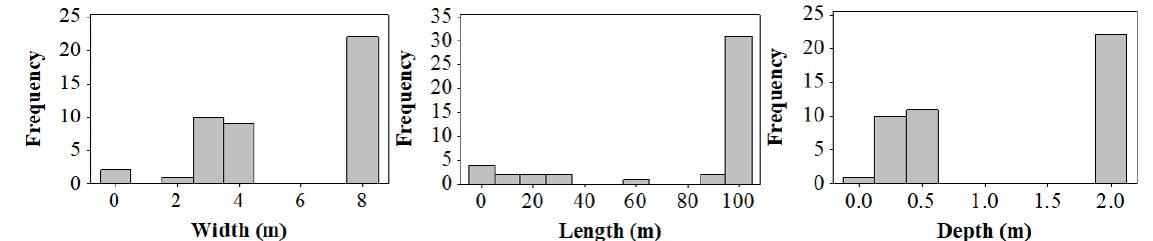
Figure 7: Histograms depicting the depth, length, and width of the extent of the spread of the plant population observed at 44 locations along the mainstream.